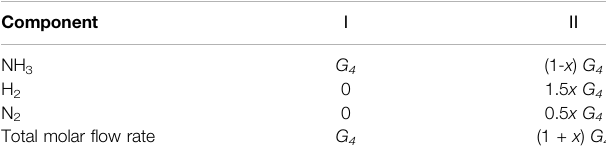
TABLE 2 | Molar fl ow rate values for each component during the decomposition reaction.